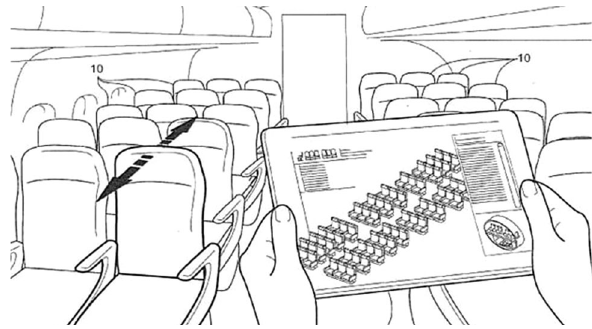
Fig. 18 Motored seating concept on board a commercial